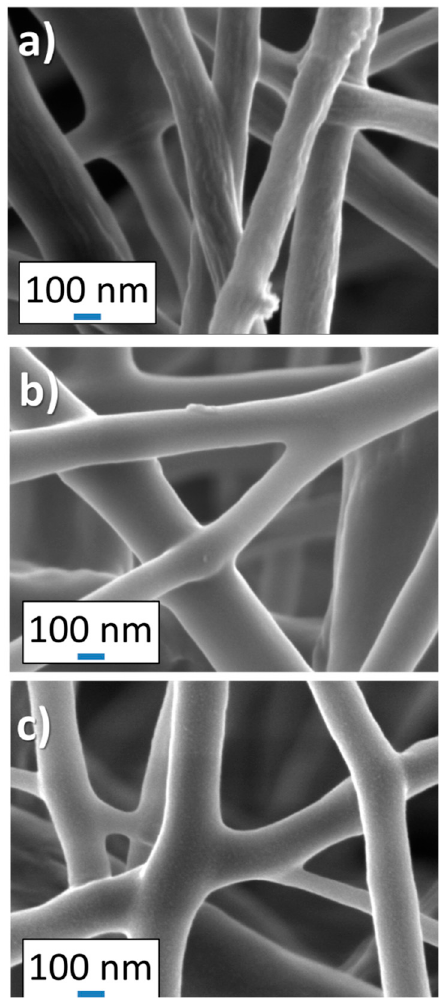
Figure 2. SEM micrographs (magnification 75,000 × ) of samples PCL/PEO-ref ( a ), PCL/PEO-Ti0.3- Ag-8 kV ( b ) and PCL/PEO-Ti0.3-Ag-5 kV ( c